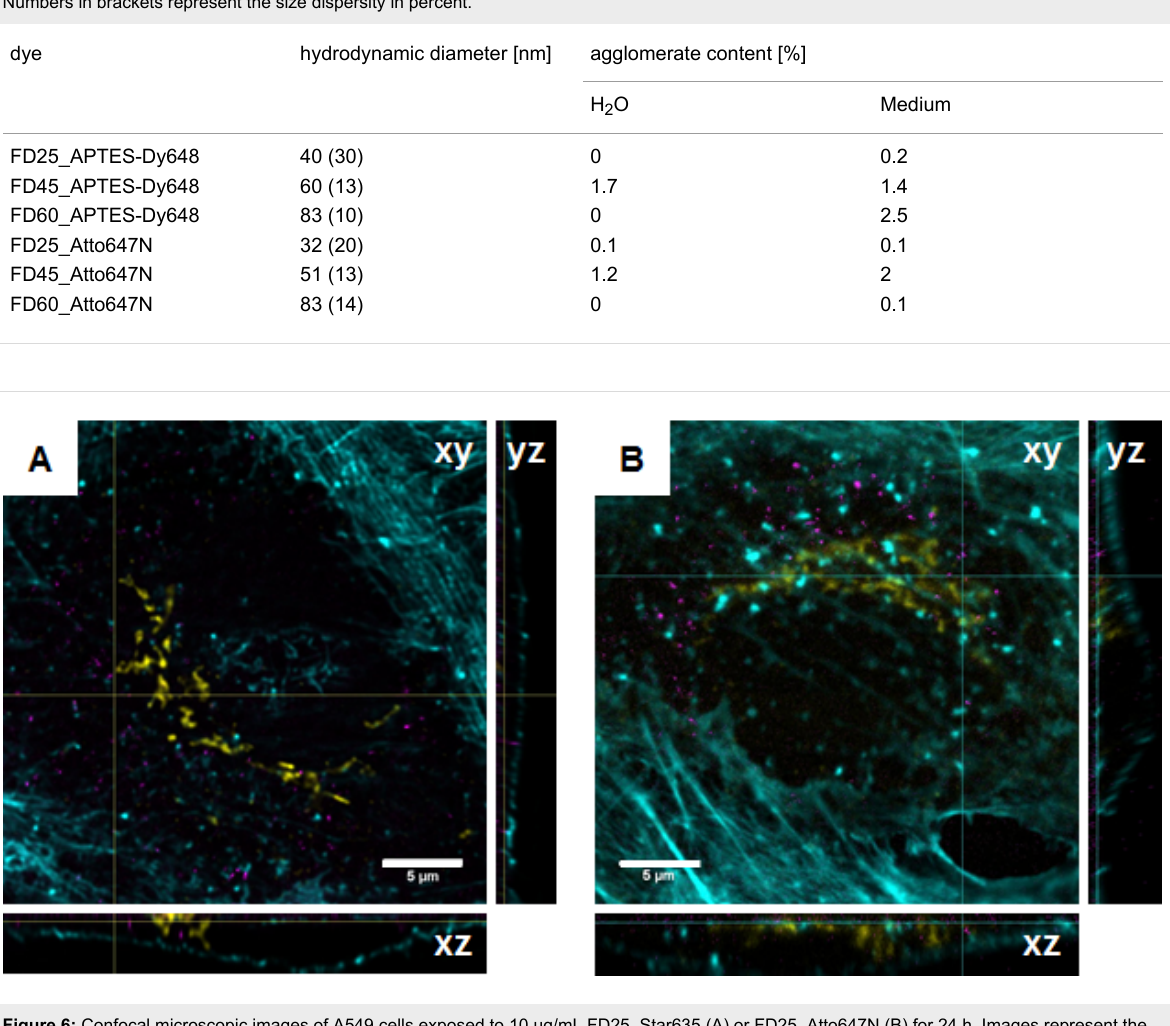
spective of the used label. Intensity profiles, derived from